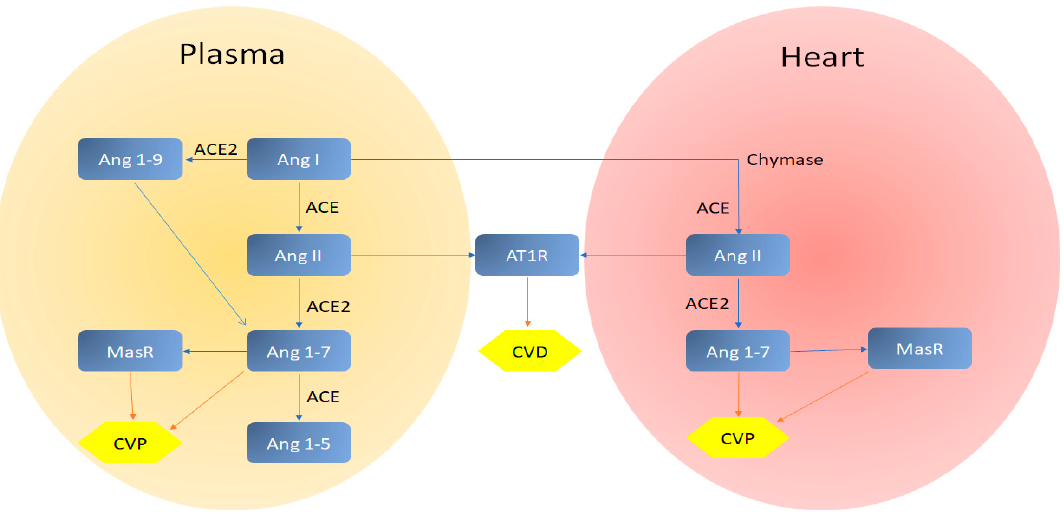
Figure 12. The metabolomic pathways of angiotensin peptide in the heart and plasma. Redrawn from Ref. [56].